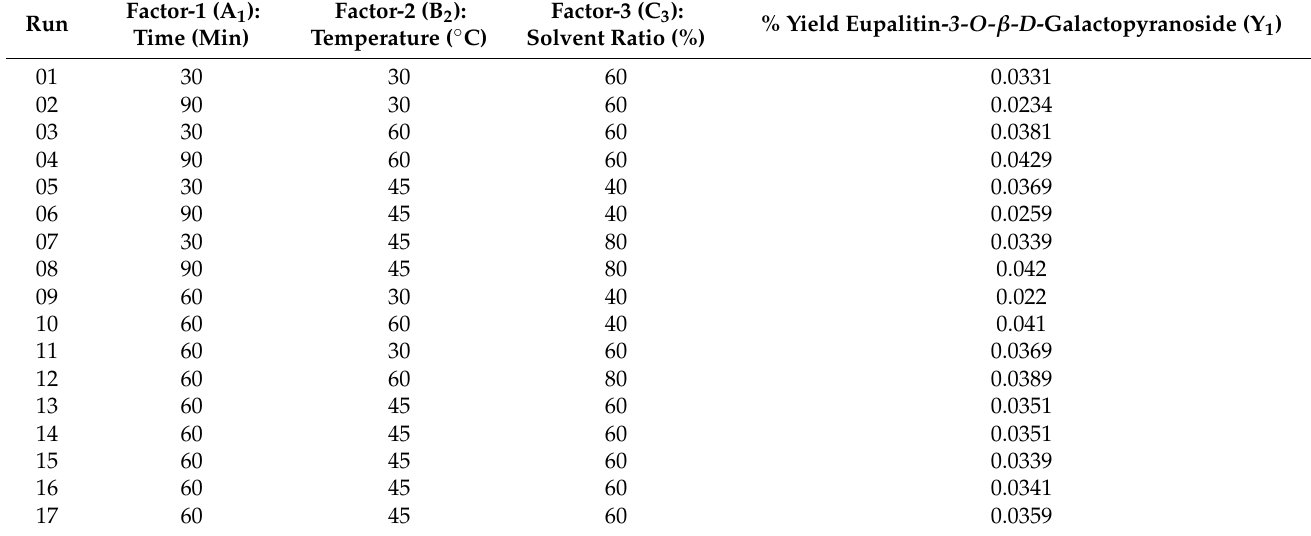
Table 5. Mentioned responses in Box–Behnken design experiment for 17 analytical